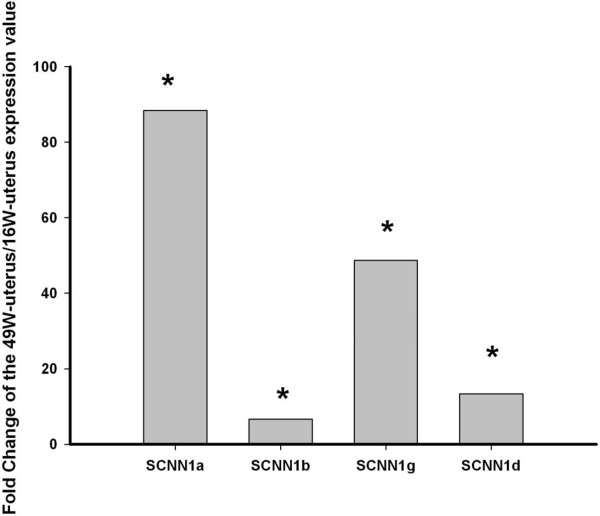
Fold change of the relative expression by qPCR of SCNN1 gene family members in active uterus (eggshell mineralizing) of 49-week-old hens compared to 16-week-old pullets. Expression in the 49-week-old adult hen active uterus was compared with expression in pullet uterus. * represents a significant difference (p < 0.05). The expressions of all four genes are significantly increased in 49-week-old adult hens compared to 16-week-old pullets.